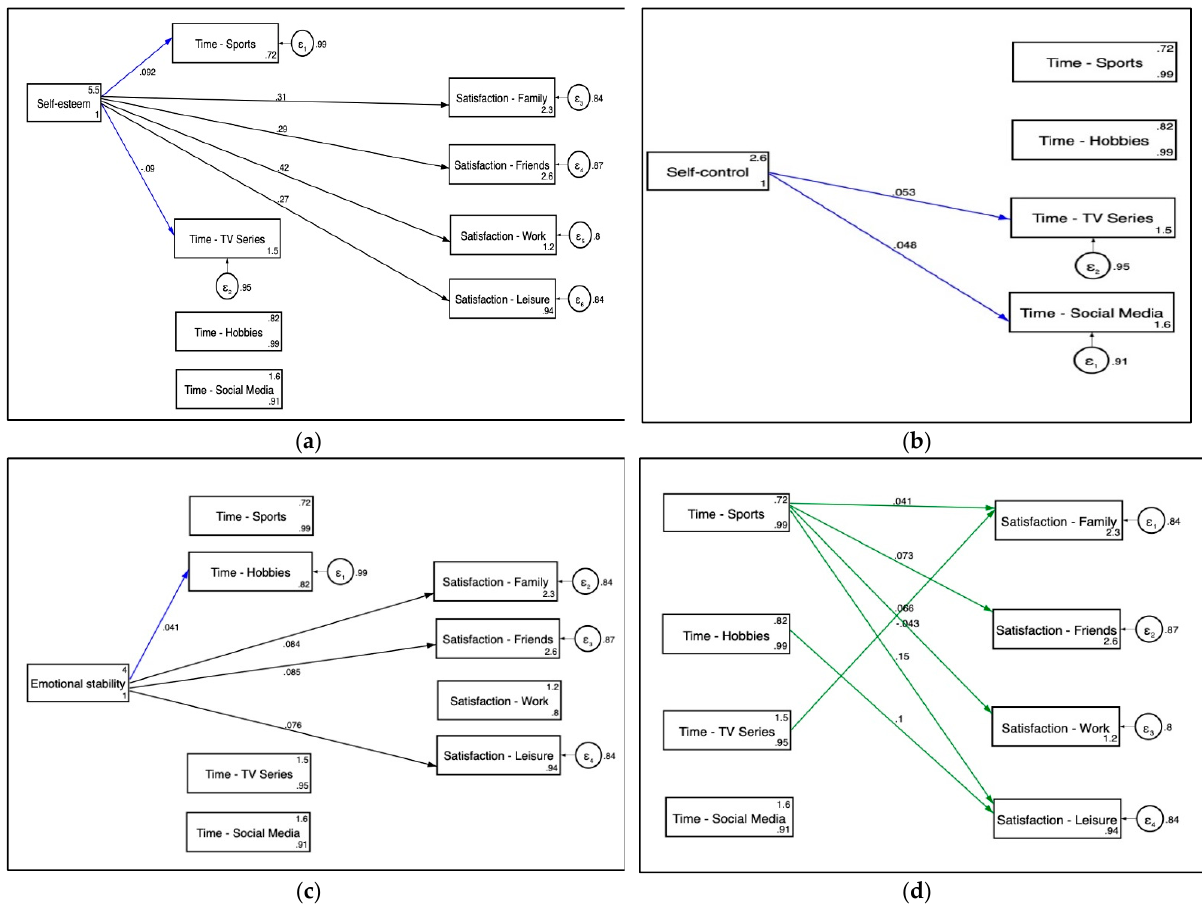
Figure 2. Significant paths on time spent on leisure activities and satisfaction. ( a ) Self-esteem on leisure activities and satisfaction. ( b ) Self-control with time spent on leisure activities. ( c ) Emotional stability on leisure activities and satisfaction. ( d ) Time spent on leisure activities with satisfaction.